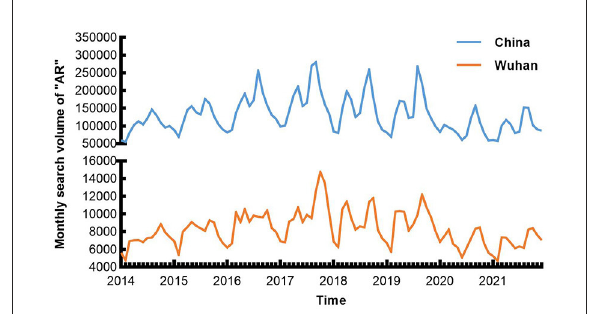
FIGURE1 The yearly search volume of “AR” in China and Wuhan through Baidu search engine from 2014 to 2021.